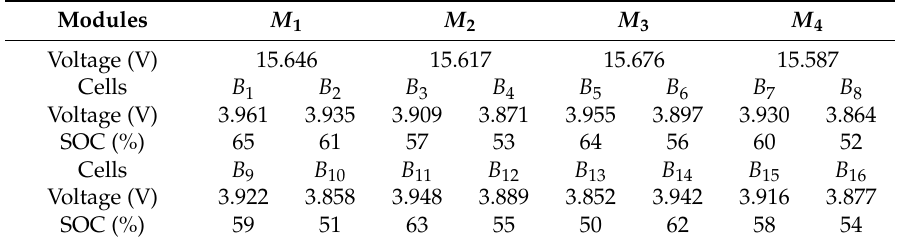
Table 1. Initial voltages of 16 cells.